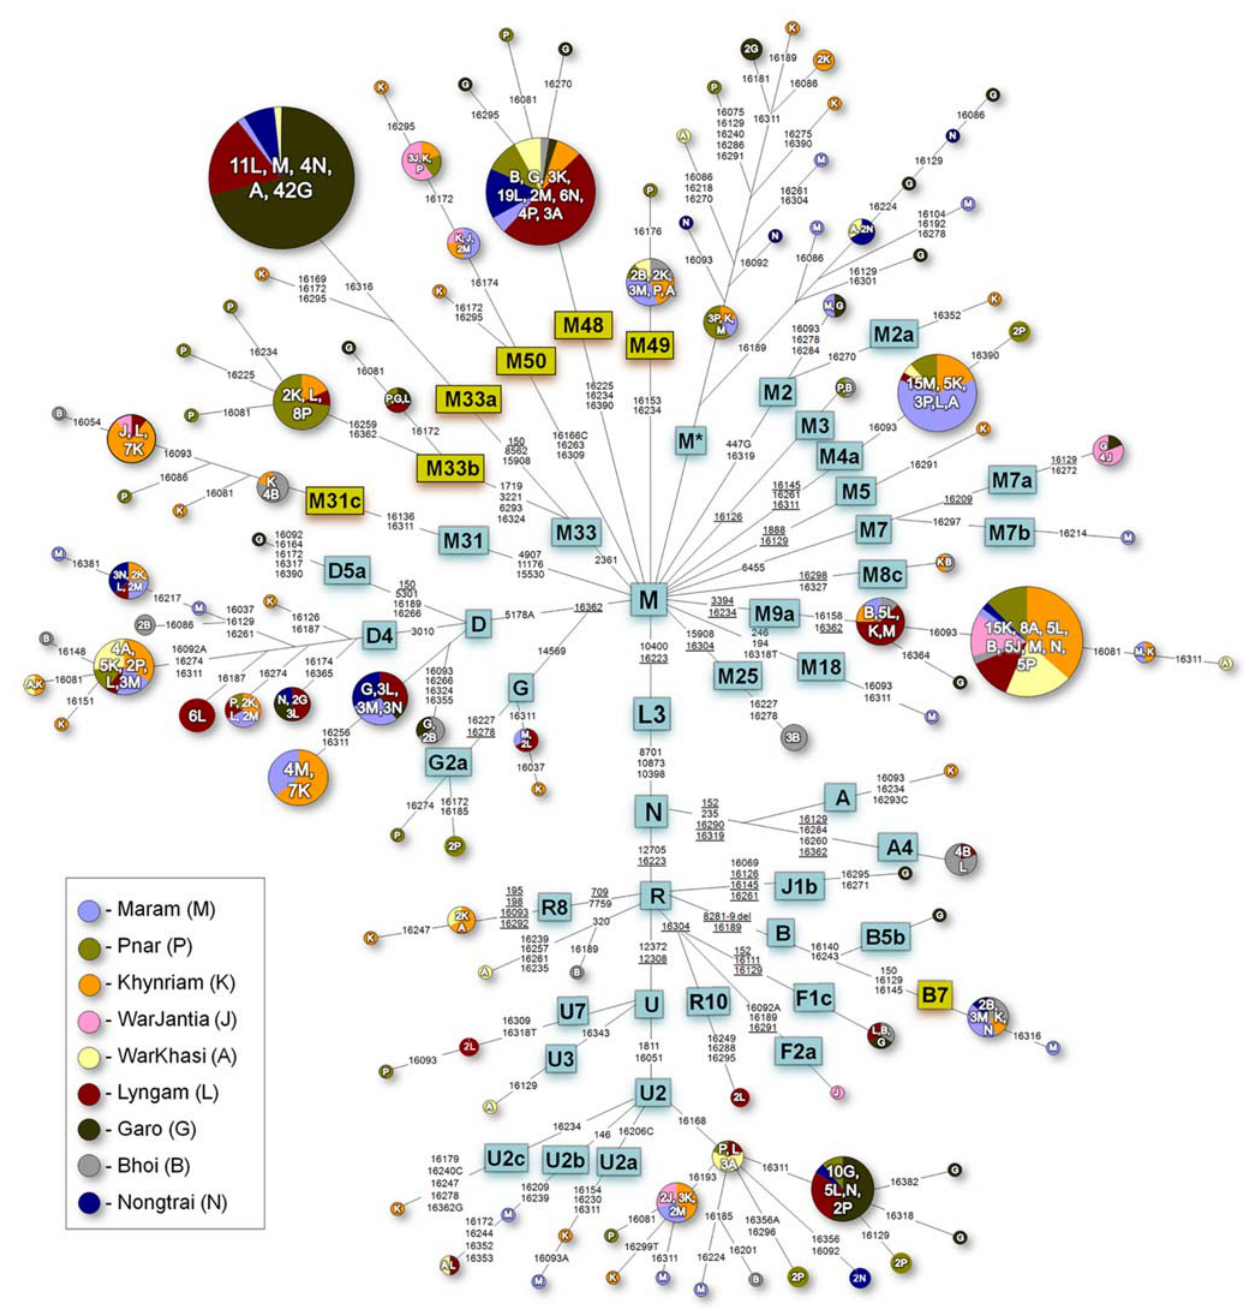
Figure 5. Tree Drawn from a Median-Joining Network of mtDNA Haplogroups Observed in Nine Meghalayan Populations. The haplogroups box in yellow colour are either new or redefined haplogroups.